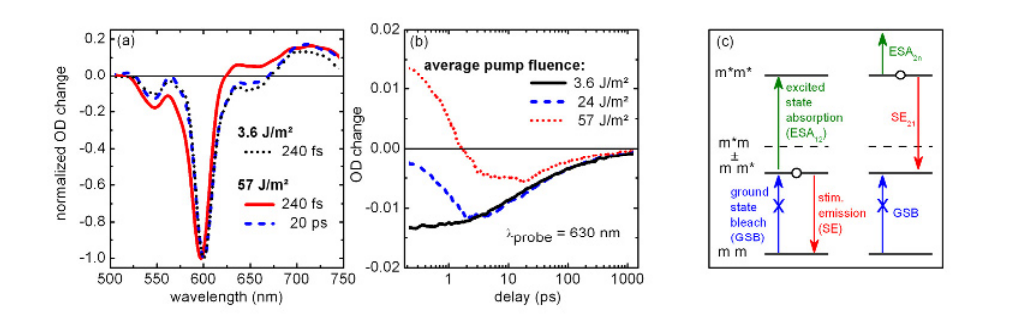
Fig. 1. (a) Normalized transient absorption spectra for low (3.6 J/m²) and high (57 J/m²) average pump fluences at two different delay times. (b) Time evolution of the transient absorption at 630 nm for different average pump fluences. (c) Energy level diagram of the signal contributions for a one- (left) and a two-exciton state (right) in case of a dimer. m and m* indicate a monomer in the ground and excited state